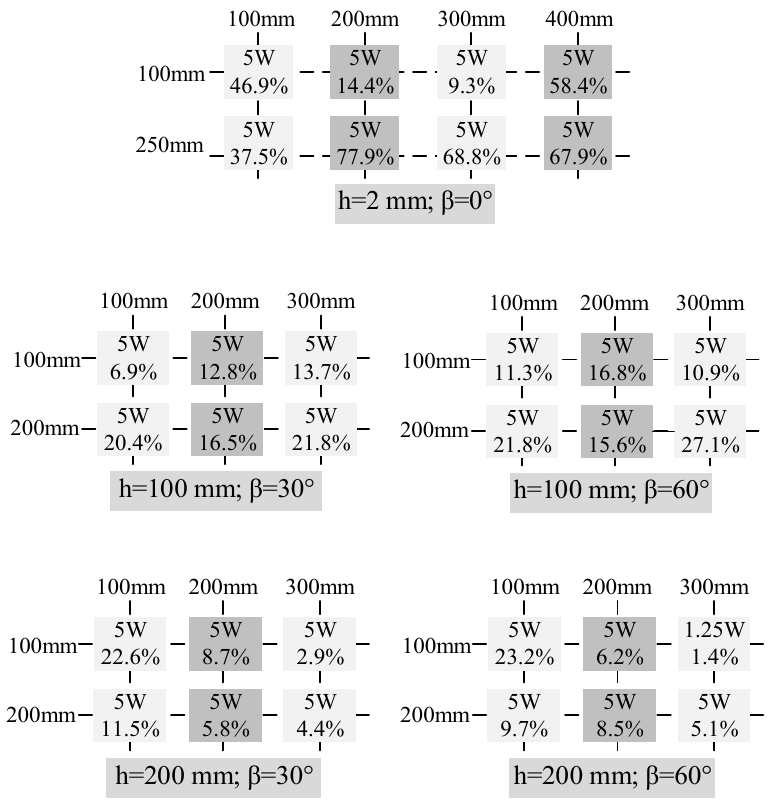
Figure 8. Output power and efficiency of the prototype. Table 3. Power amplifier (PA) power and efficiency with different positional and angular misalignment of receiver.